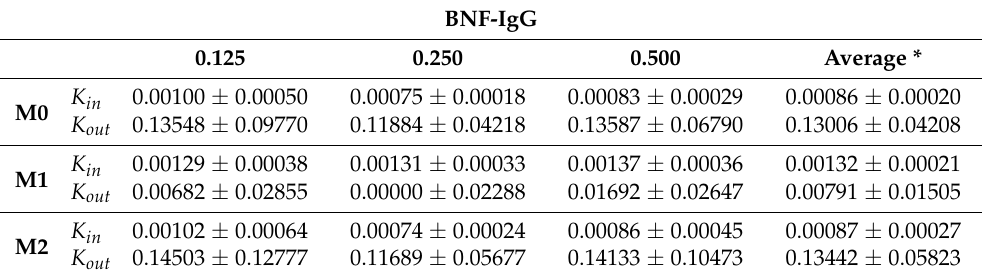
Table 4. Values of K in and K out obtained from the fitting shown in Figure 2 for BNF-IgG using mean